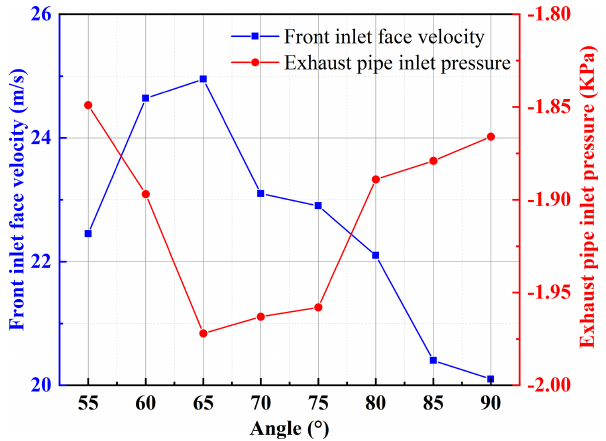
Figure 5. Influence of the outlet diameter on the flow field charac- teristics.